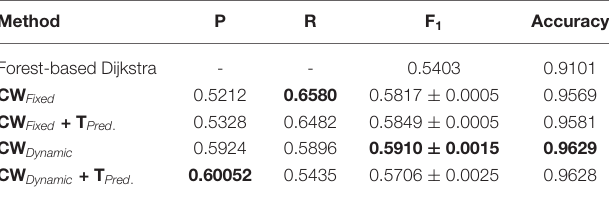
TABLE 6 | Results on VEVIO dataset